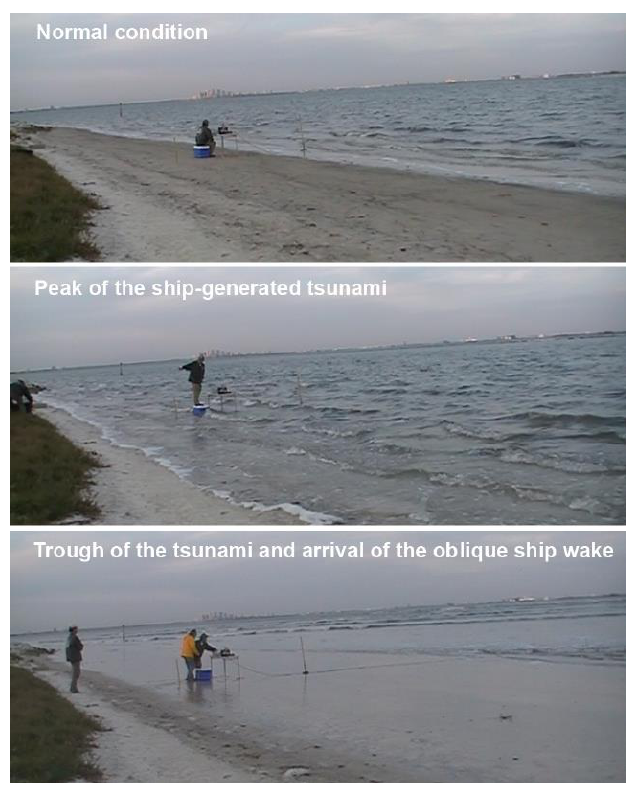
Figure 2. Photos of the ship-generated tsunami. Upper image: shoreline condition before the arrival of the tsunami wave. Middle image: at the peak of the tsunami. Lower image: at the trough of the tsunami.